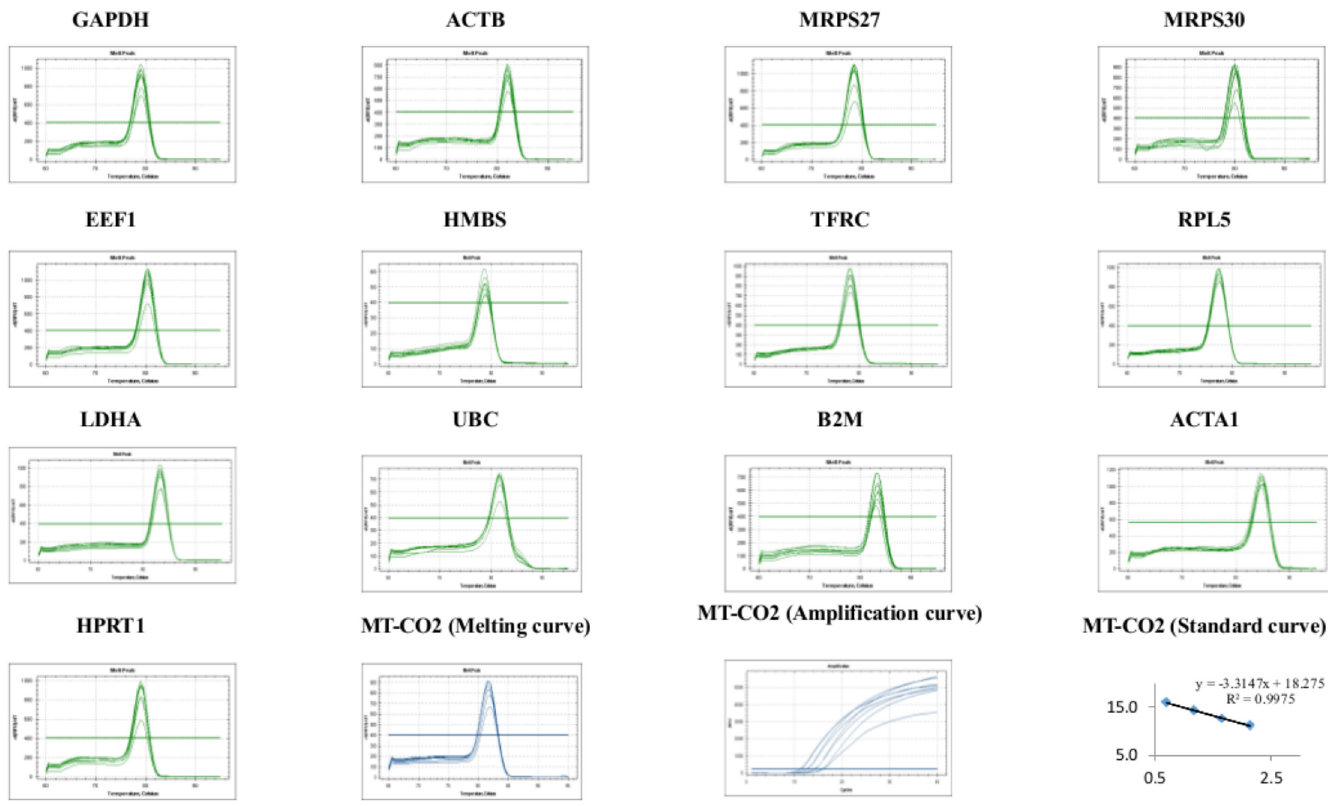
Fig 1. Specificity of RT-qPCR amplification. Melting curves (dissociation curves) of the 13 reference genes amplicons after the RT-qPCR reactions, all showing one peak. Melting, amplification and standard curves for mitochondrially encoded cytochrome c oxidase II (MT-CO2) target gene are also showed.